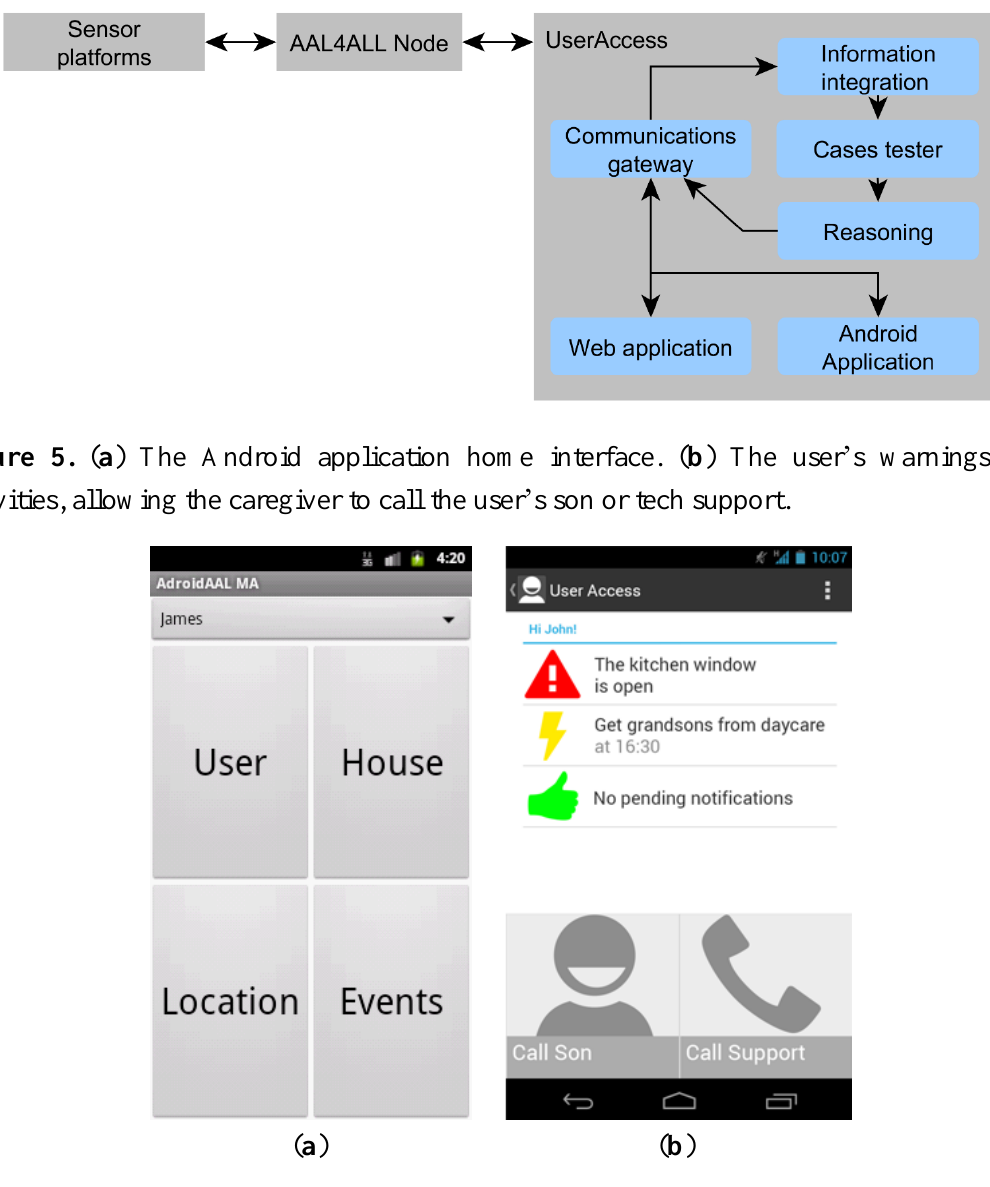
Figure 4. UserAccess architectural